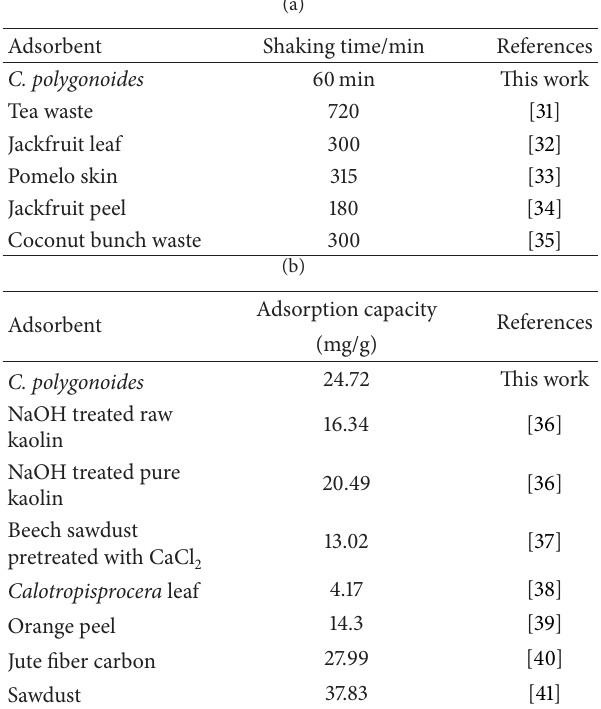
Table 3: (a) Comparison of contact time for dye adsorption. (b) Comparison of adsorption capacity of C. polygonoides with other reported adsorbents.